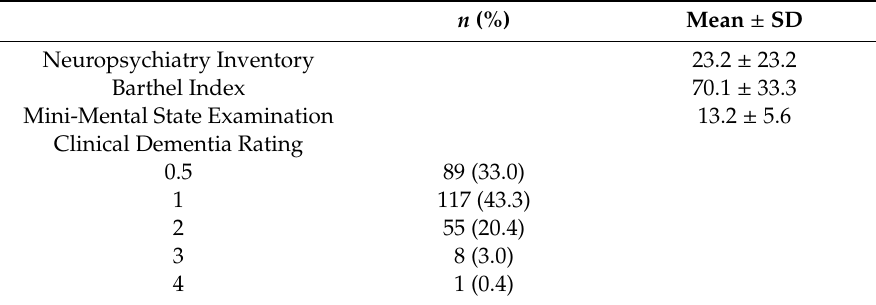
Table 3. Clinical profiles of people with dementia.